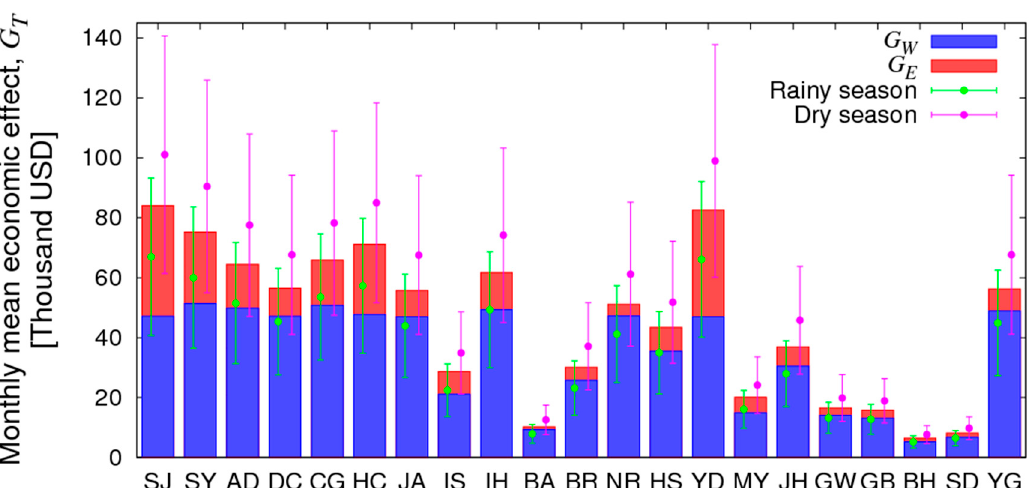
Figure 4. Economic benefit ( G T ) from 21 multipurpose dams. Blue bar represents the benefit from sale of water ( G W ) and red bar represents benefit from sale of electricity ( G E ). Green circle is the total benefit in the rainy season and magenta circle is the total benefit in the dry season. The error bars in the dry and rainy seasons of each dam indicate the minimum and maximum of the 90% confidence interval.